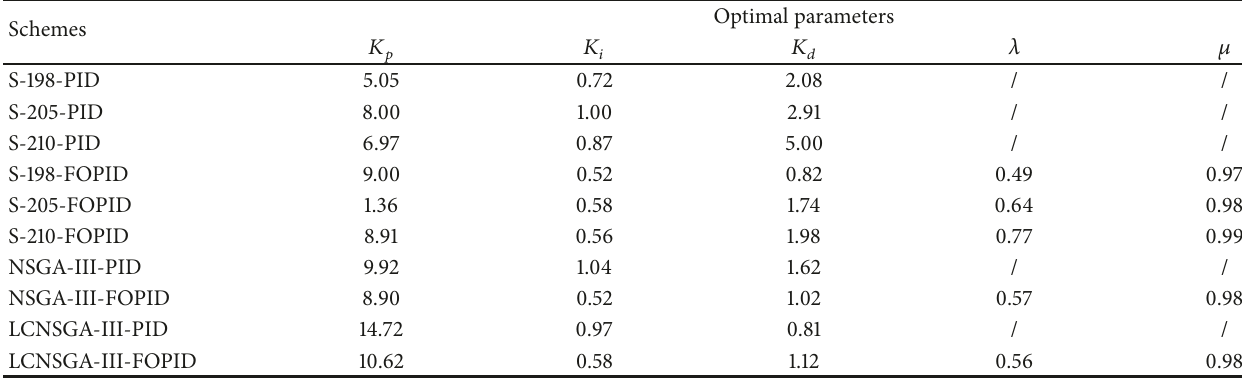
Table 4: Optimal control parameters for nonlinear PTGS using different schemes.